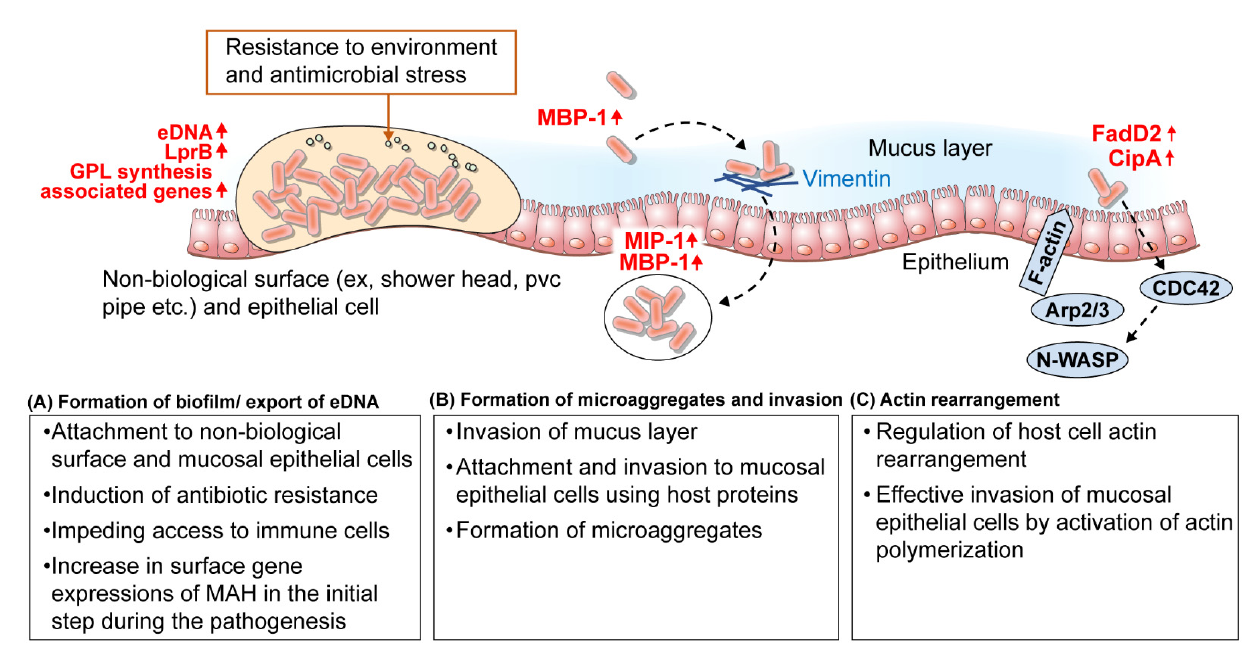
Figure 1. Summary of the strategy of MAH related to mucosal epithelial cell adhesion and invasion. ( A ) Biofilm formation and eDNA export, which greatly contributes to colonization, persistence and drug resistance, are important survival strategies for MAH. MAH lipoprotein (LprB) and GPL-related genes are involved in biofilm formation, and biofilms are involved in adhesion to mucosal epithelium and non-biological surfaces including PVC pipes, shower heads, and hot tubs. ( B ) MAH binds to host proteins such as vimentin, and attaches to epithelial cells, and planktonic bacteria are rapidly recruited to form microaggregates. Furthermore, the MAH microaggregates interact with the host protein filamin A through MIP-1 and further manipulate the host cytoskeleton to efficiently invade the host epithelium. ( C ) MAH can effectively invade mucosal epithelial cells by cytoskeletal rearrangement of host cells by activating the Cdc42 signaling pathway by fadD2, cipA, and other downstream transcriptional regulators. CipA, a domain similar to the PXXP motif of the human piccolo protein; eDNA, extracellular DNA; Fad2, fatty acyl coenzyme A synthase; GPL, glycopeptidolipid; LrpB, leucine-responsive regulatory protein B; MBP-1, microaggregate binding protein 1; MIP-1, microaggregate invasion Protein-1.